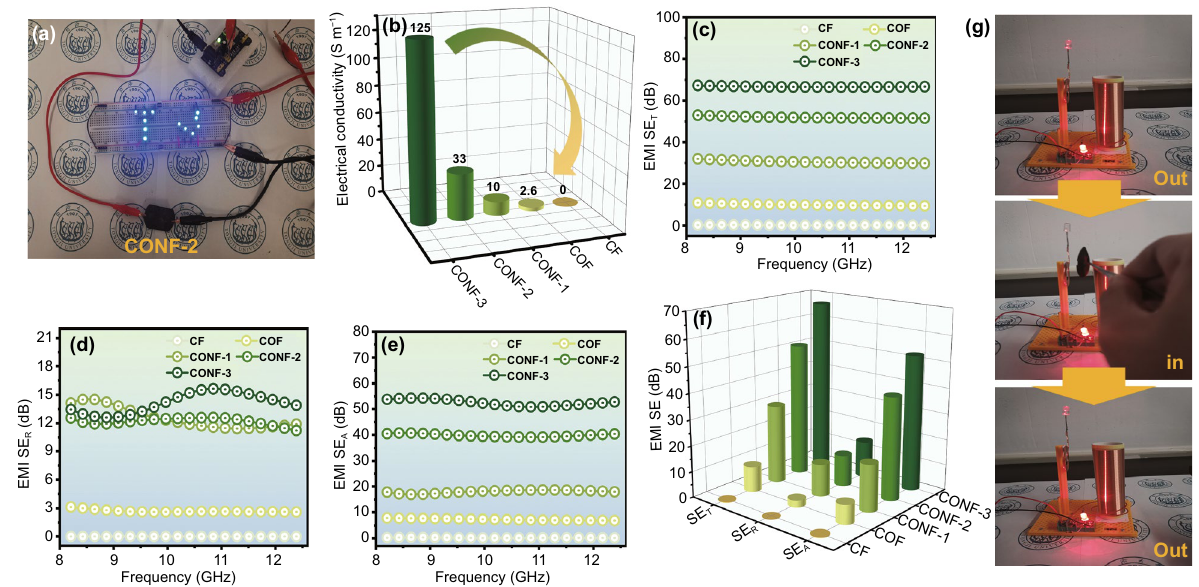
Fig. 8 a Digital image of the CONF-2 that light the “TJ” LED lamps; electrical conductivity b , SE T c , SE A d , and SE R e in X-band of as-pre- pared films; f comparison of average SE T , SE A , and SE R ; g the digital images of a facial wireless power transmission device with